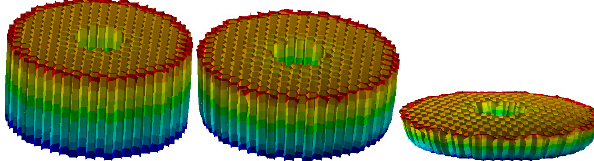
Figure 4. Simulation results of static pressure.